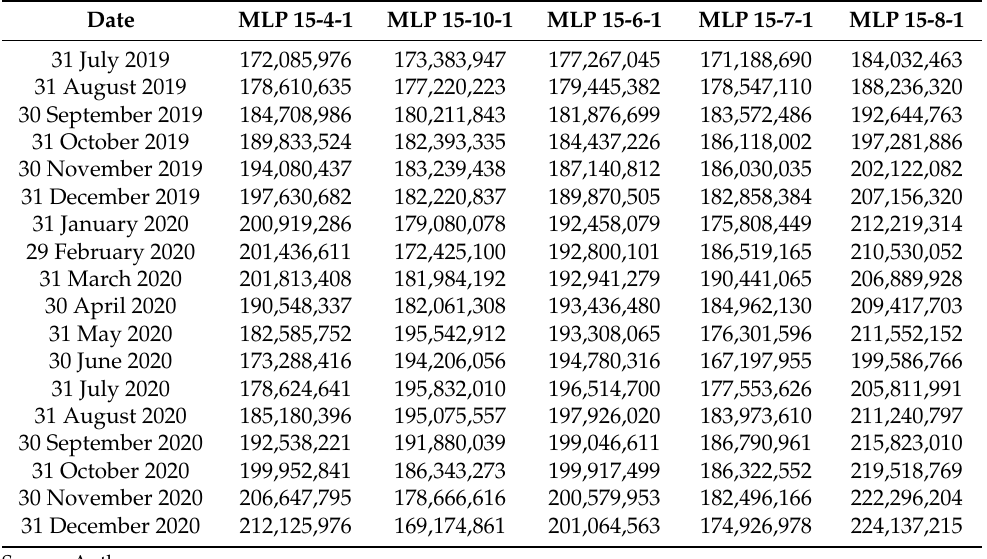
Table 5. Predicted exports from July 2019 to December 2020 according to the retained ANN (Experi- ment 2).